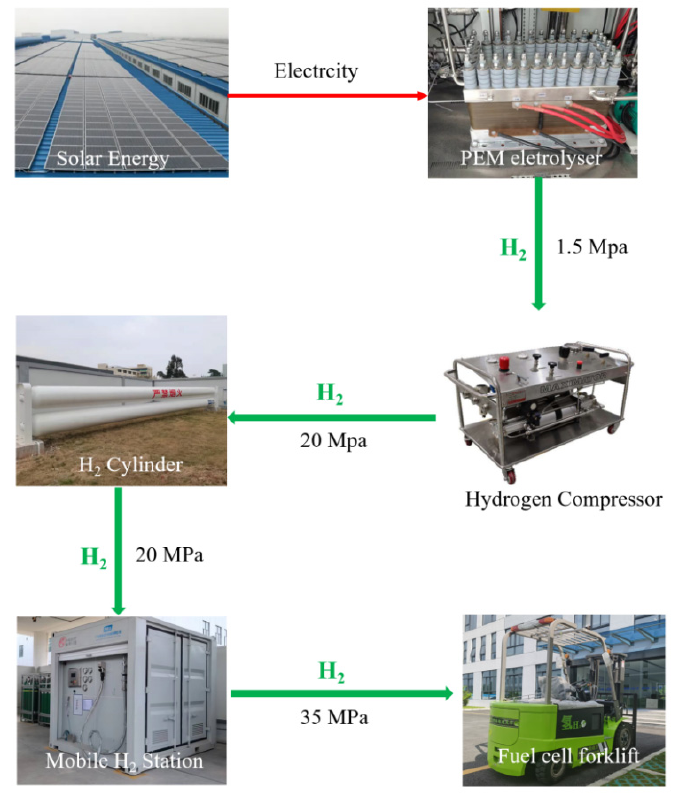
Figure 8. Integrated hydrogen production and hydrogenation station.